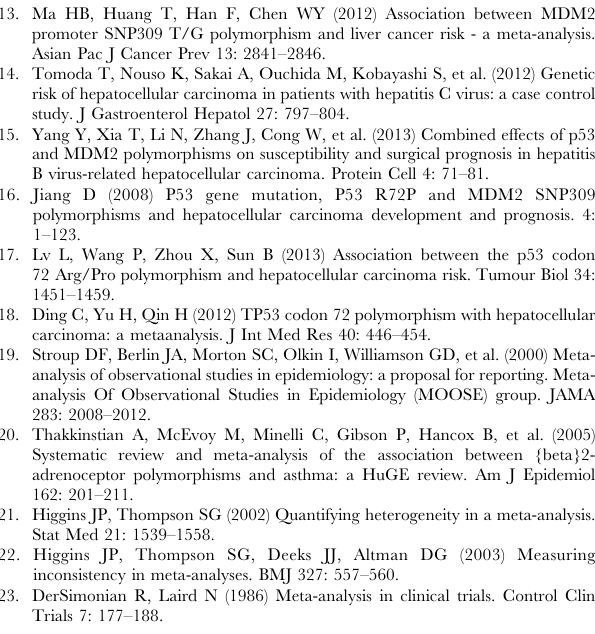
Figure S1 Flow diagram of included studies for this meta- analysis. (TIF) Figure S2 Funnel plot analysis to detect publication bias. Each point represents a separate study for the indicated association. A Funnel plot for MDM2 SNP309 polymorphism in the overall analysis (recessive model GG vs. TG + TT: P = 0.180); B Funnel plot for TP53 Arg72Pro polymorphism in the overall analysis (recessive model ProPro vs. ArgPro + ArgArg: P=